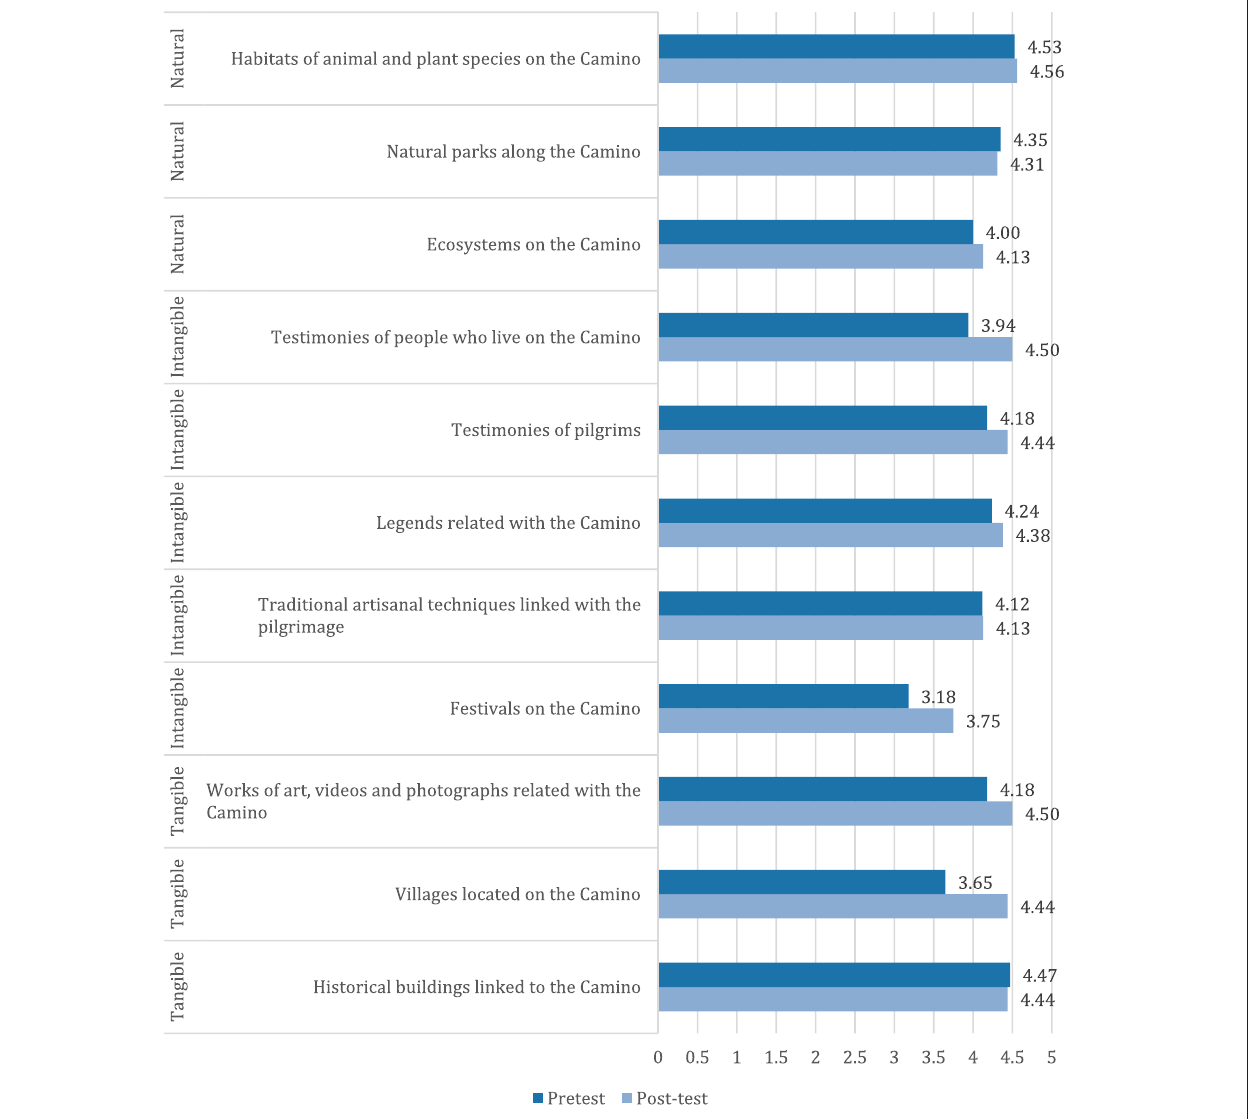
FIGURE 3 | Mean importance of the heritage components of the Way of St.